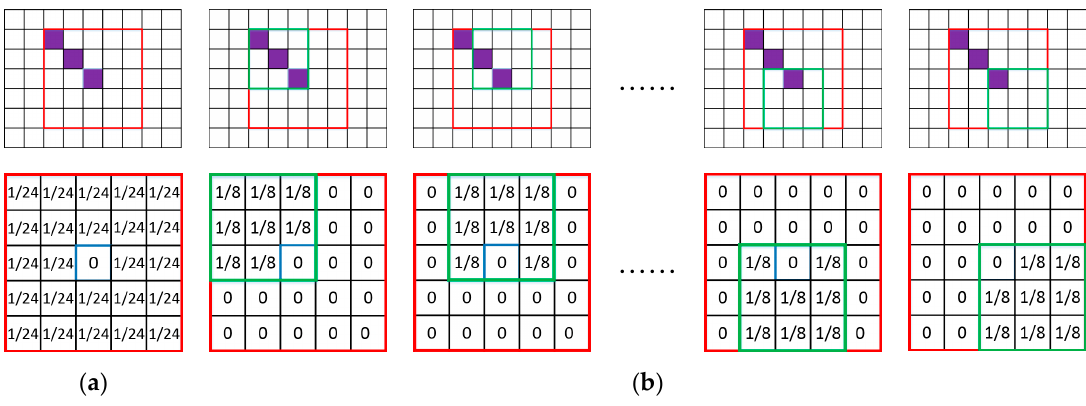
Figure 1. Analysis between the center test pixel and neighboring pixels in a single local window. The purple squares represent anomalous pixels, and the white squares represent the same category background pixels: ( a ) ideal distribution of neighboring pixels; ( b ) the neighborhood contains anomalous pixels; ( c ) the center pixel is a background pixel.